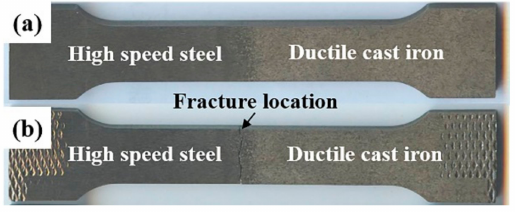
Figure 11. The tensile sample state before ( a ) and after ( b ) the tensile test.